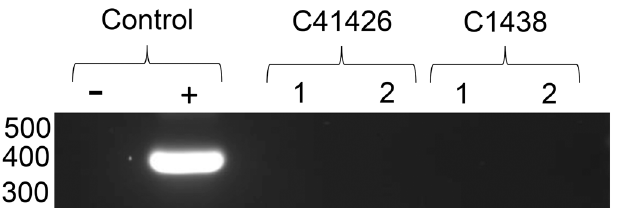
Fig 3. Analysis of na ï ve susceptible bovines that received blood transferred from deer challenged with B . bovis by nested PCR. Calves 41426 and 1438 received blood from deer challenged with either B . bovis blood stabilate or a larval extract supernatant containing B . bovis sporozoites, respectively. Amplicons were separated in 2% agarose by electrophoresis for visualization. Genomic DNA from 1: pre-inoculation and 2: five weeks post-inoculation. Molecular size is indicated on the